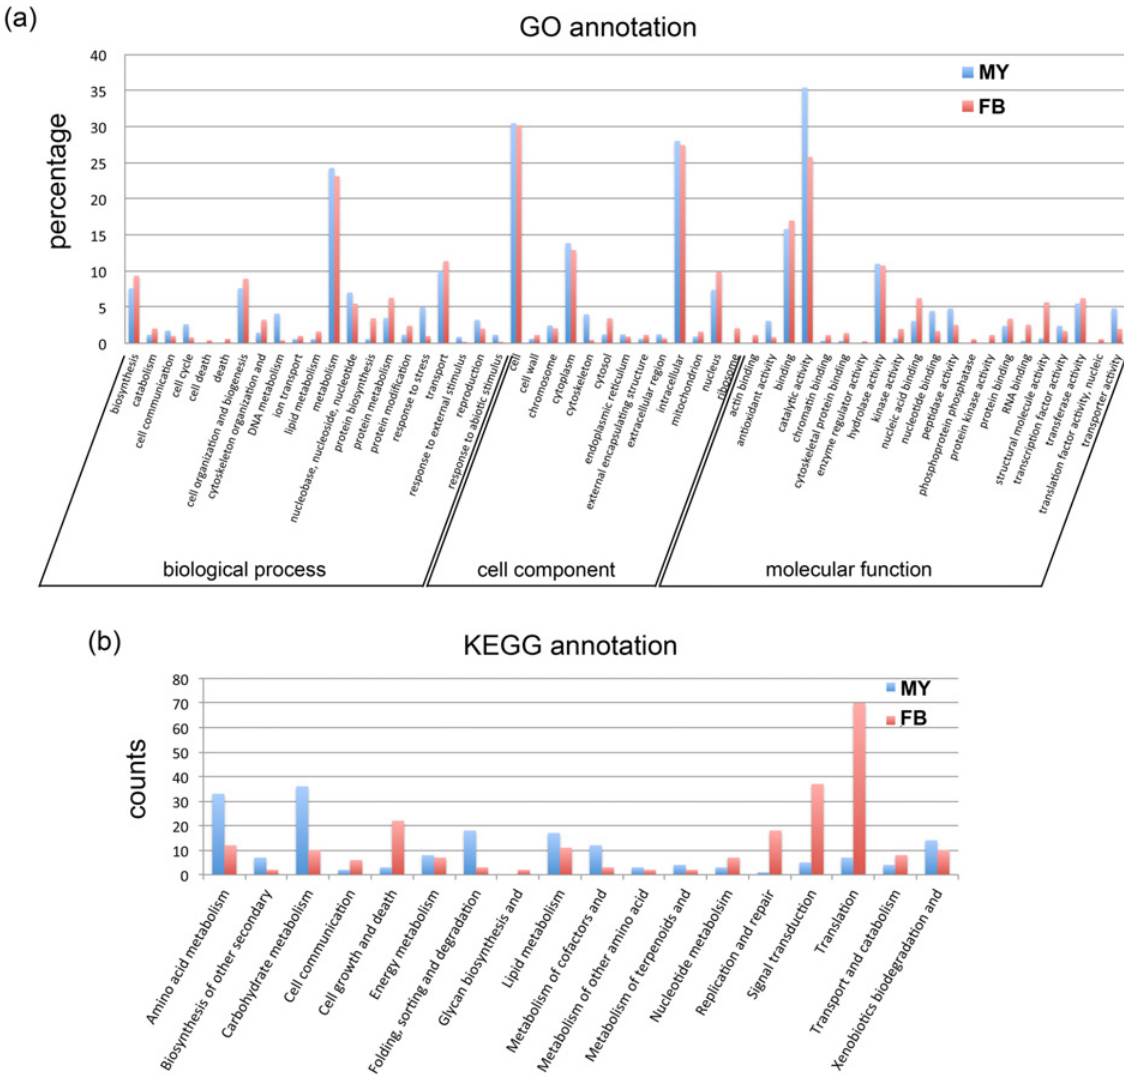
Fig 2. Gene ontology classification and KEGG annotation of DEGs between wild-type fruiting body and liquid cultured mycelium. MY: unigenes upregulated in liquid cultured mycelium, FB: unigenes upregulated in wild-type fruiting bodies. (a) GO annotation. 2,282 unigenes from DEGs were analyzed with blast2GO to obtain the GO terms. And the GO term were classified with CateGOrizer and separated into three major categories. (b) KEGG annotation. 2,282 unigenes from DEGs were submitted to KAAS to get the KEGG metabolic pathway